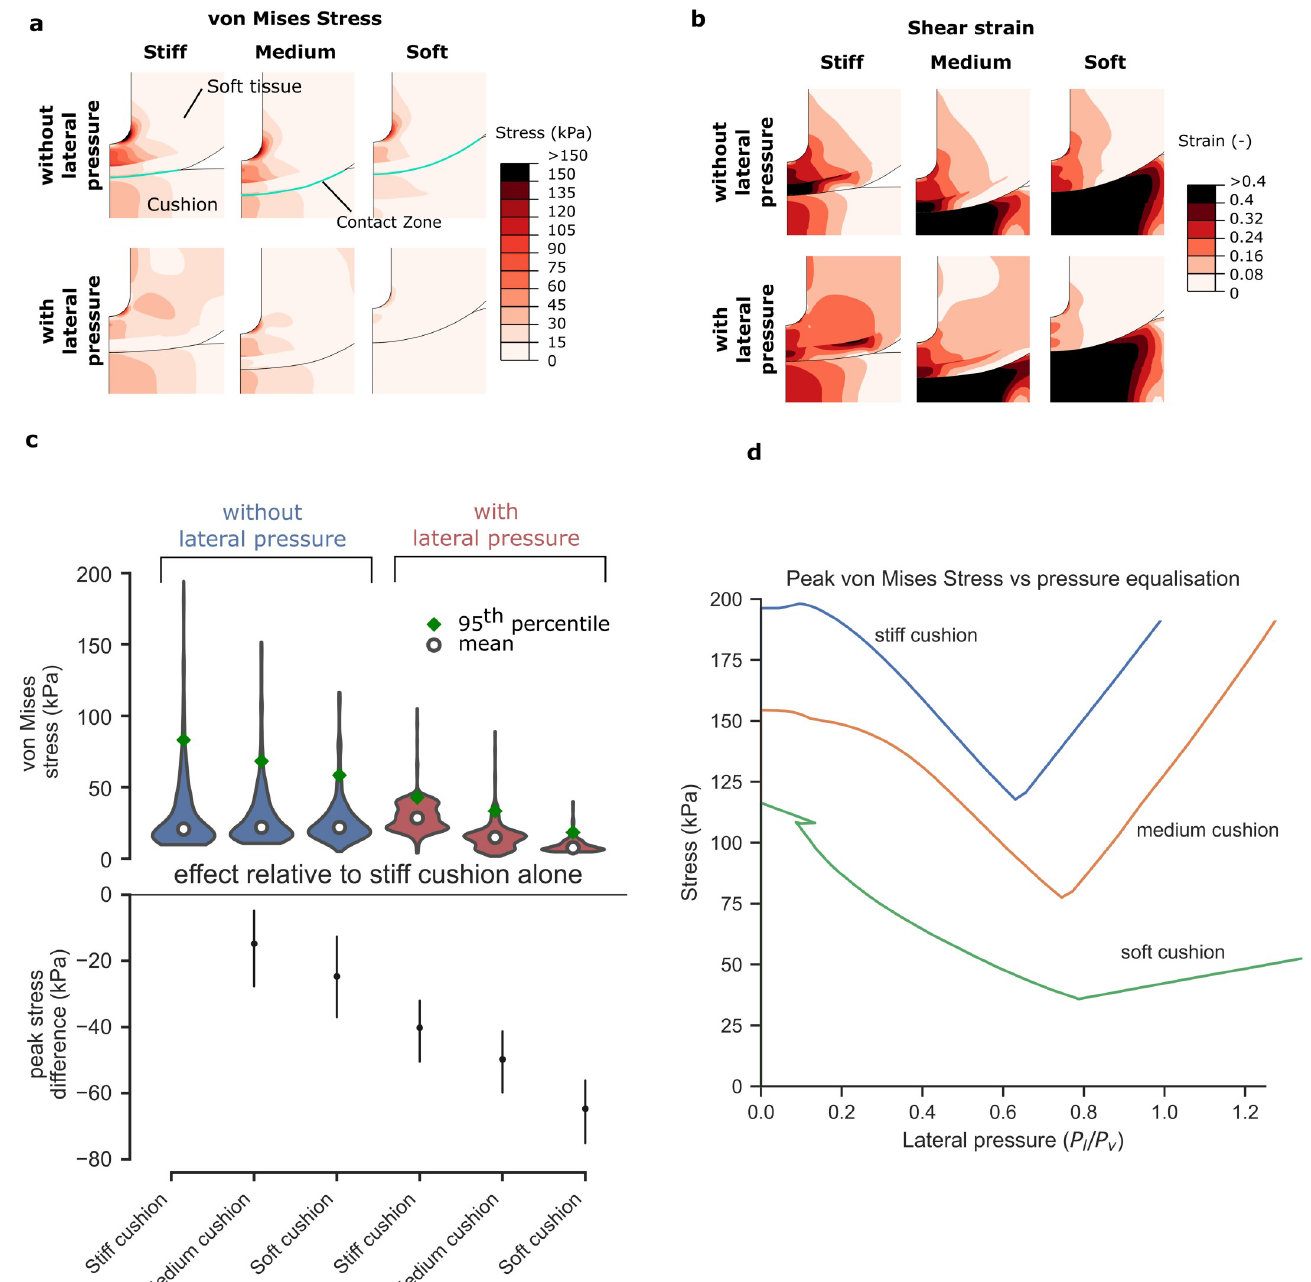
Fig 4. Applying lateral pressure is more effective than changing cushion stiffness. While the contact area varies substantially with cushion stiffness, the pattern of internal stress remains similar (a)—stress is concentrated at the bony prominence. Shear strains in the fat and skin are lower when a softer cushion is used (b), but strains within the muscle remain high for all cushions. These strains are reduced when lateral pressure is introduced. All three cushions benefit from the introduction of lateral pressure, with a soft cushion and lateral pressure providing the lowest von Mises stresses (c) [Violin plots show mean and 95th percentile values, stress difference plot shows the peak difference relative to a stiff cushion only with 95% confidence intervals]. As lateral pressure is gradually increased, the von Mises stress decreases until an optimum pressure is reached (d); beyond this pressure, von Mises stresses begin to increase again. While the magnitude of the optimum lateral pressure is different for each cushion, the ratio of lateral to vertical pressure is between 0.63 and 0.79 for all cushions